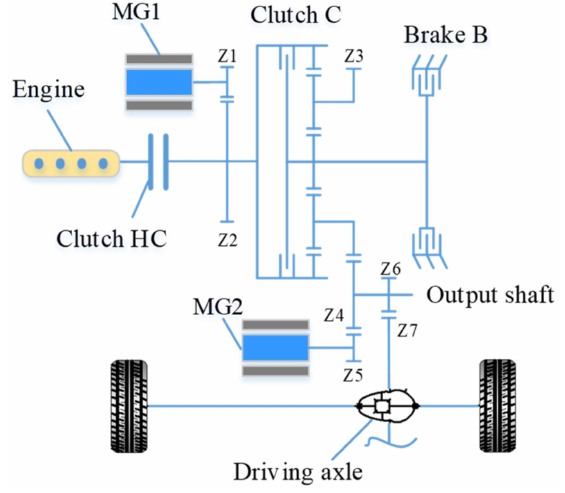
Figure 1. Structure of the two-speed series-parallel hybrid system.